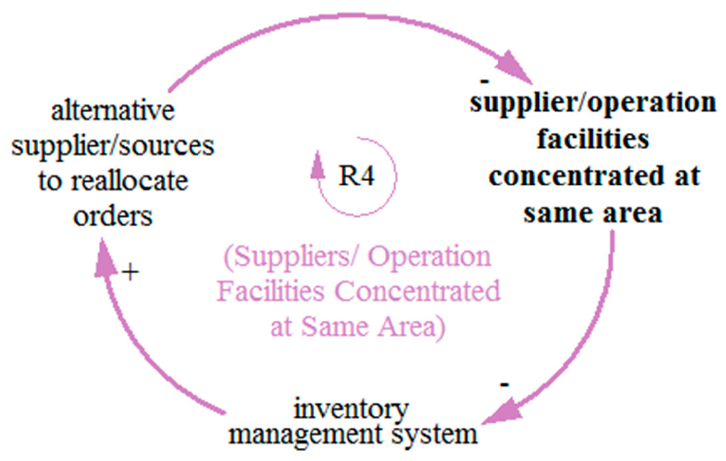
Figure 9. Reinforcing loop R4 (suppliers/operation facilities concentrated at same area).